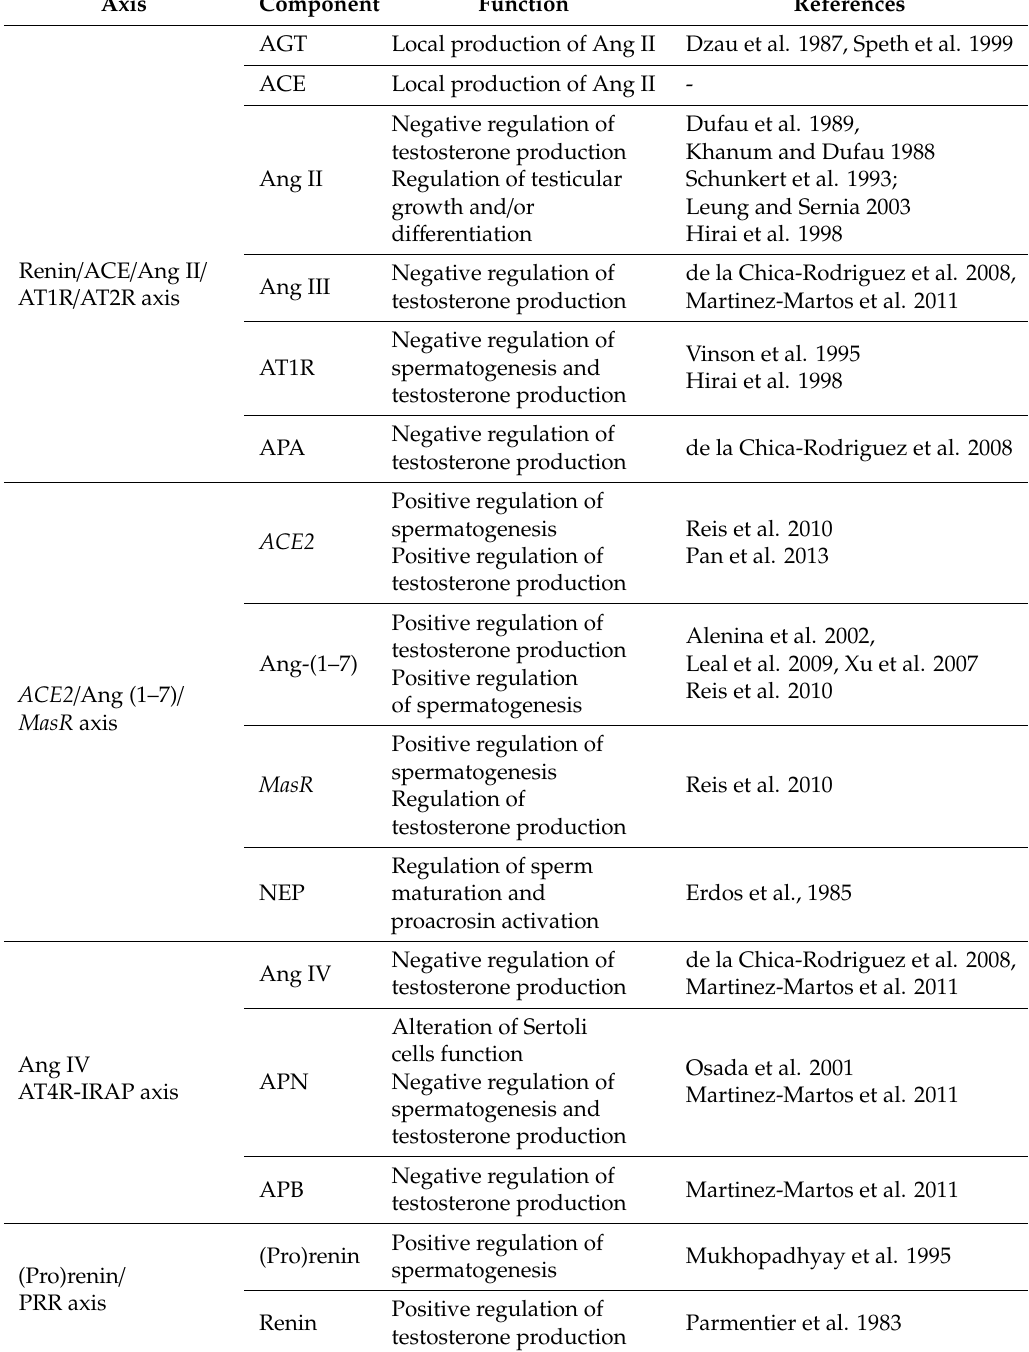
Table 1. Regulation of the testicular function by local